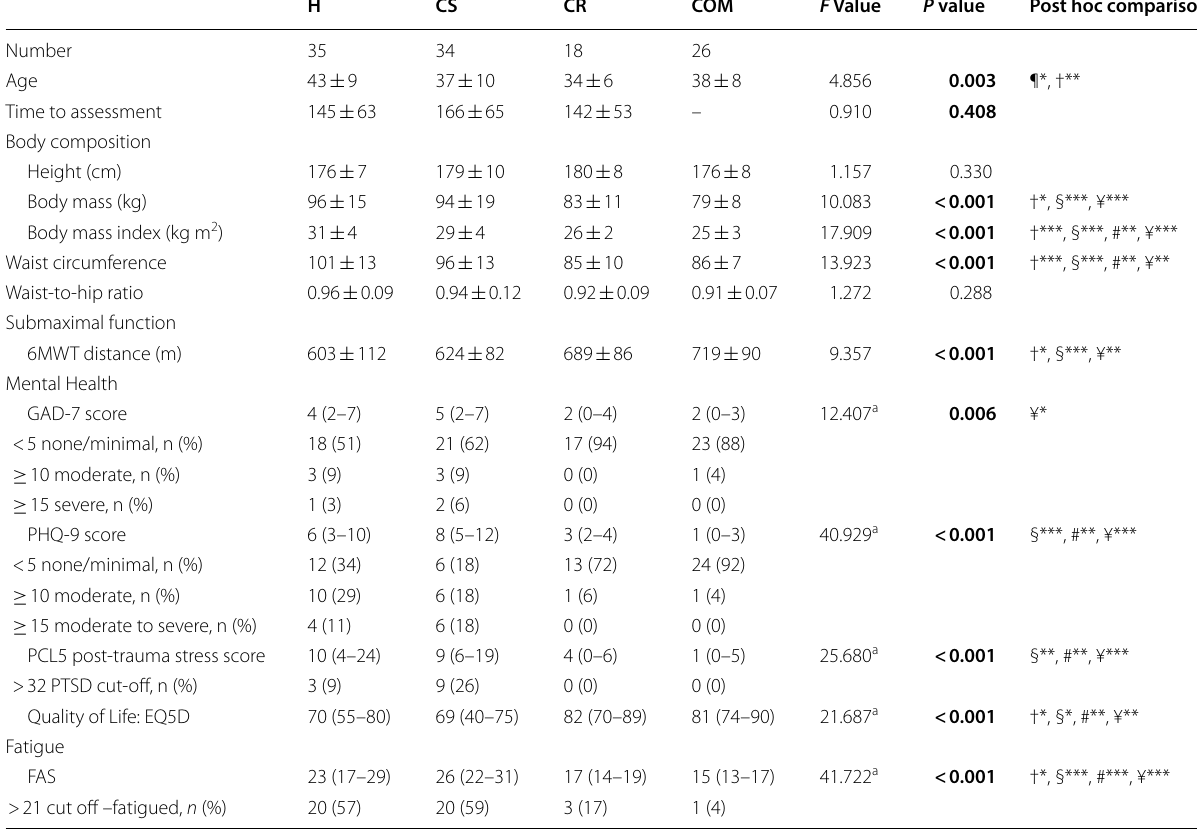
Bold denotes a statistically significant result, with level indicated by